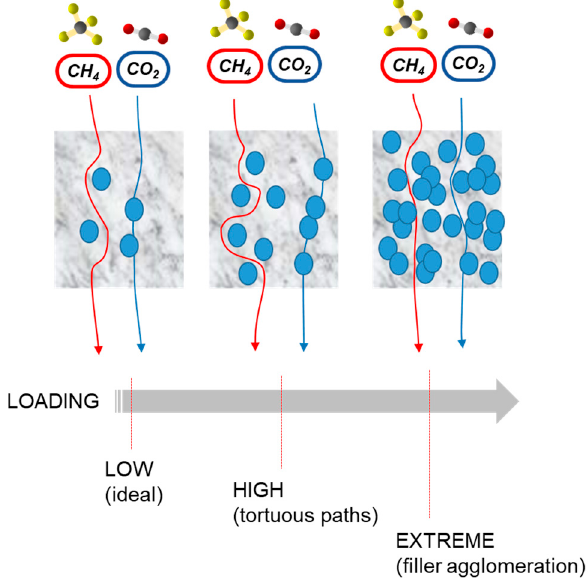
Figure 8. Scheme of the gas transport through MMMs with increasing filler